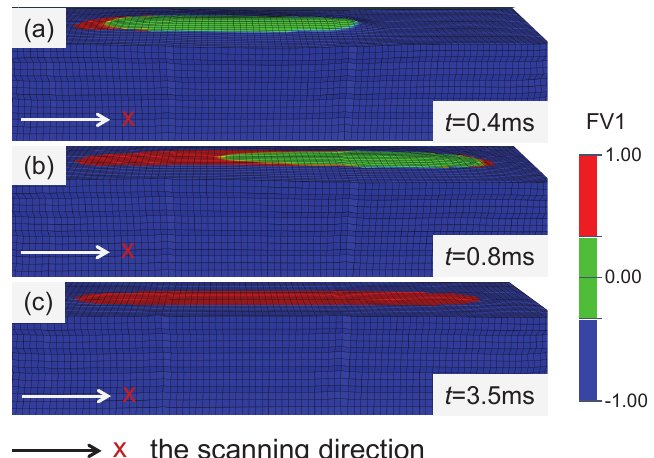
Figure 8. The melting solidification process of Ti-6Al-4V alloy at different times. Green represents the liquid area and red represents the solid area, deformation is magnified by 10 times. ( a ) t = 0.4 ms; ( b ) t = 0.8 ms, and ( c ) t = 3.5 ms.